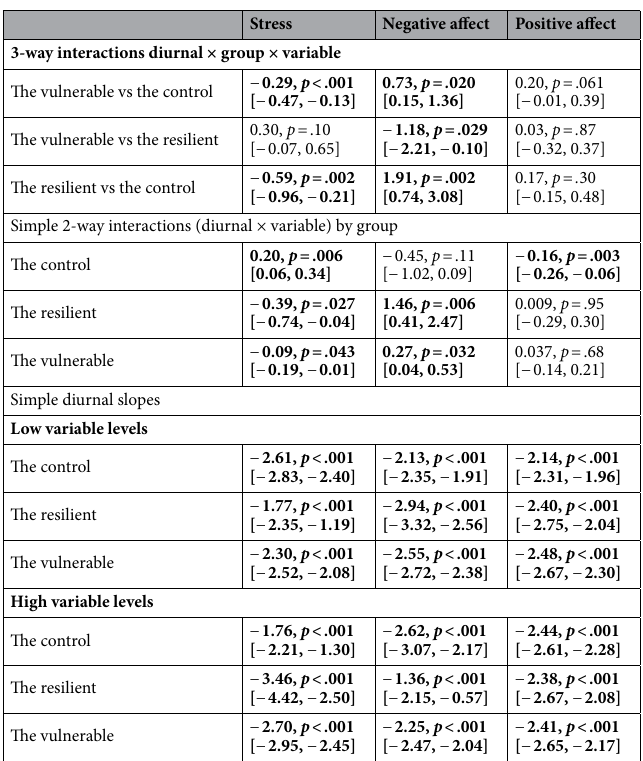
Table 3. 3-way diurnal cortisol slope × group × stress/affect interactions and simple slopes. Bold highlights p < .05. Variable in the table varies by column and is either stress, negative affect, or positive affect. Estimates are unstandardized regression coefficients for interactions or simple slopes, followed by p -values, and 95% confidence intervals. All estimates are from linear mixed models with all covariates